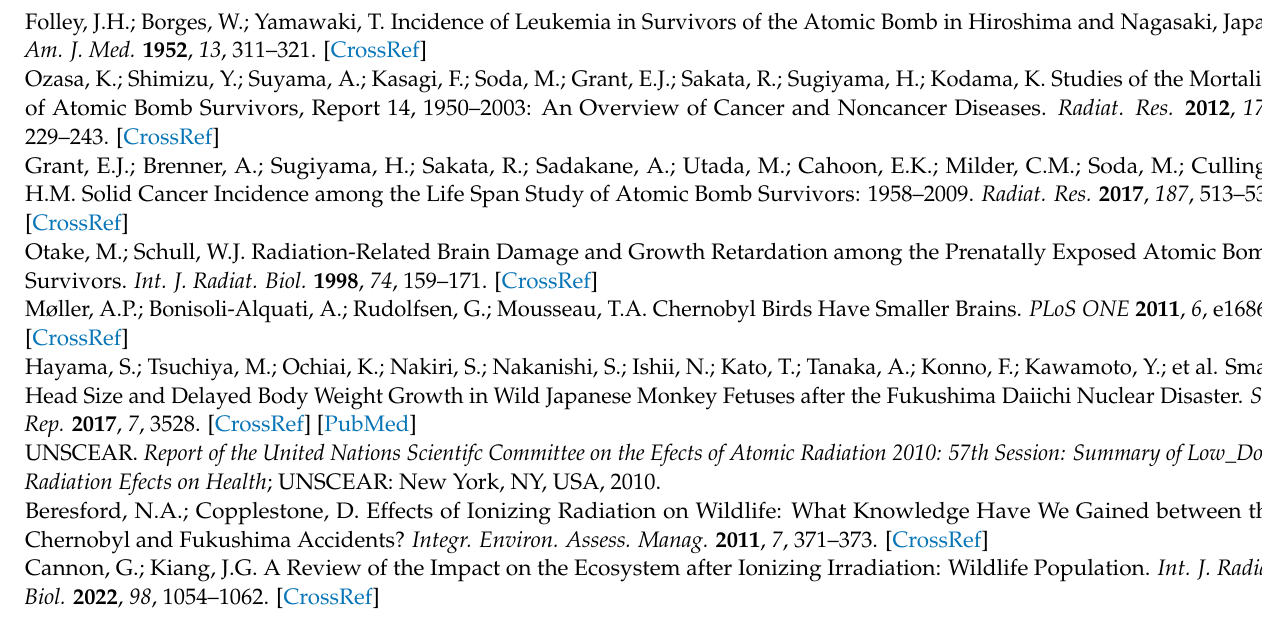
Table S4: Differential expression analysis of neurohormones and neurotransmitters. The process (from Gen Ontology) is indicated for each gene; Figure S1: Quantification of signal intensity of oxytocin by determining the integrated